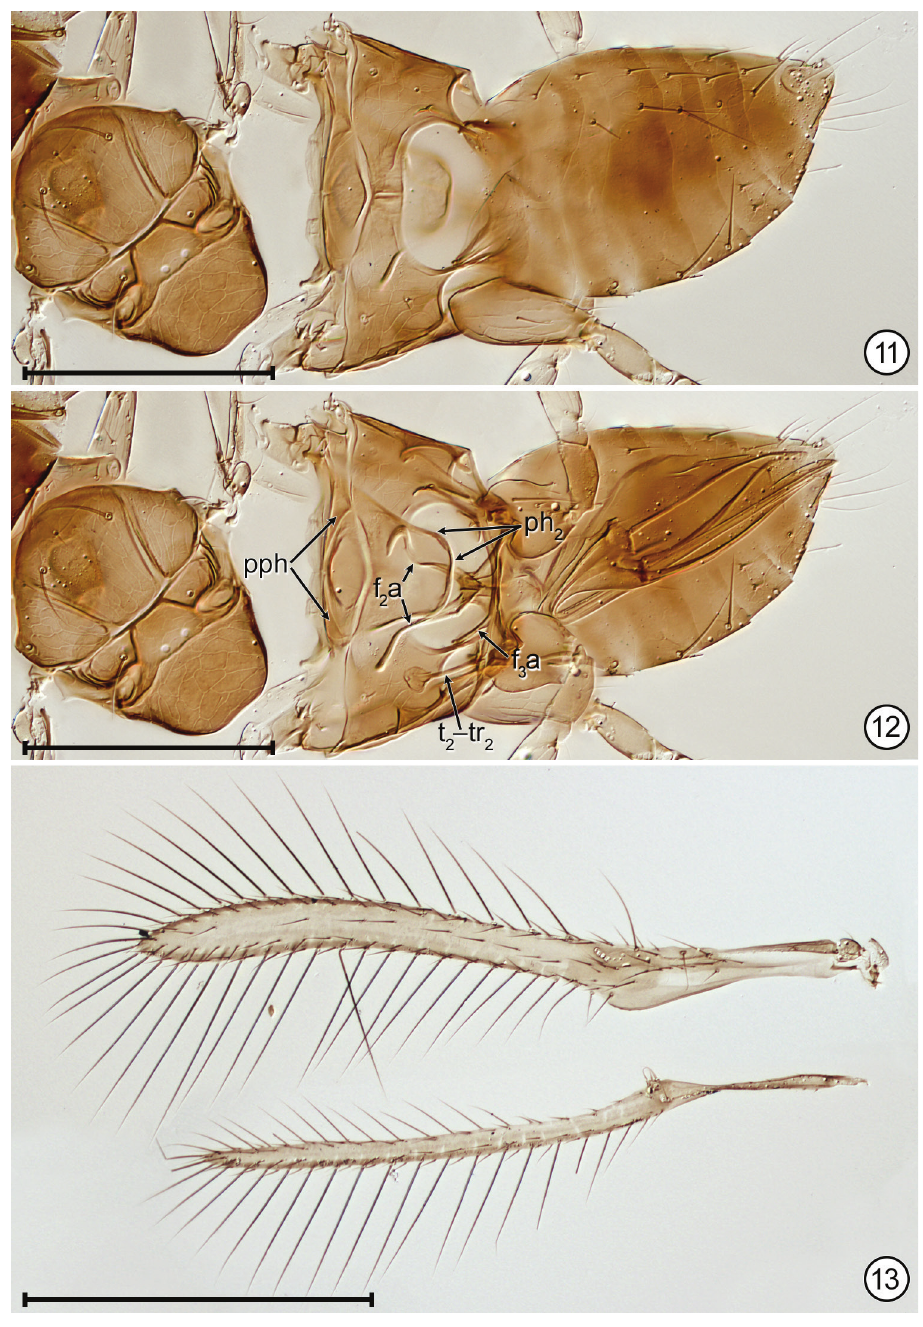
Figures 11–13. Anaphes quinquearticulatus. 11 holotype mesosoma + metasomadorsal 12 holotype mesosoma + metasoma, ventral as seen through body 13 paratype wings. Scale bars: 100 μm ( 11, 12 ), 200 μm ( 13